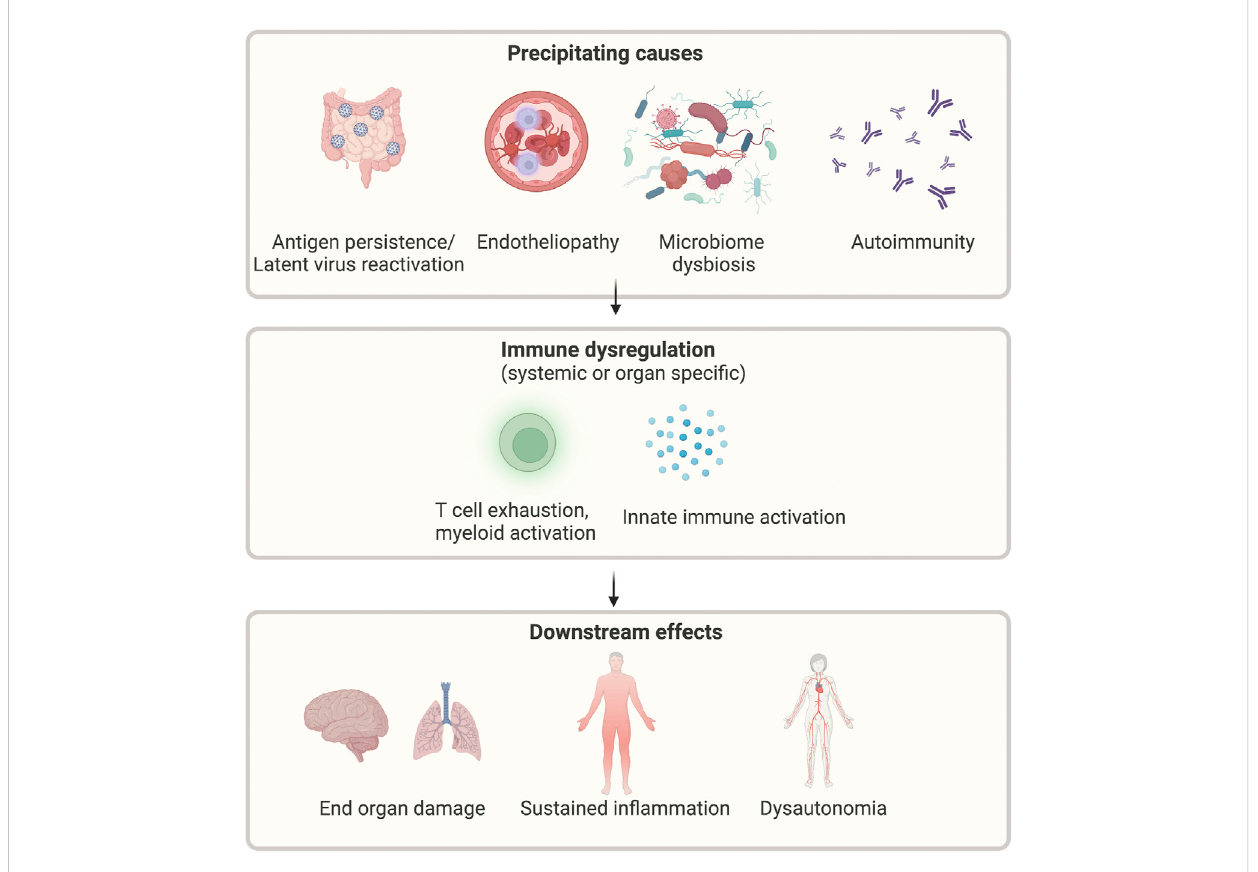
FIGURE 3 Proposed mechanisms of long COVID. Legend: Multiple possible precipitants, including persistent virus, reactivation of latent viruses, altered microbiome, endothelial dysfunction, and autoimmunity, may lead to ongoing immune activation and subsequent systemic symptoms. Created with BioRender.com.